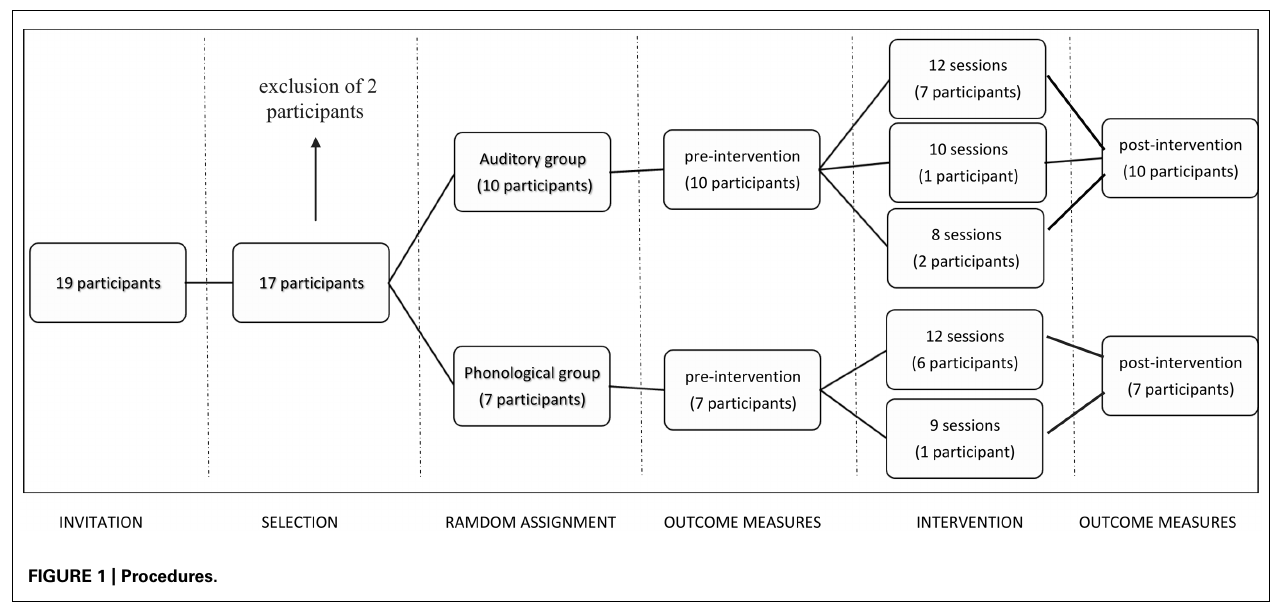
FIGURE 1 | Procedures.